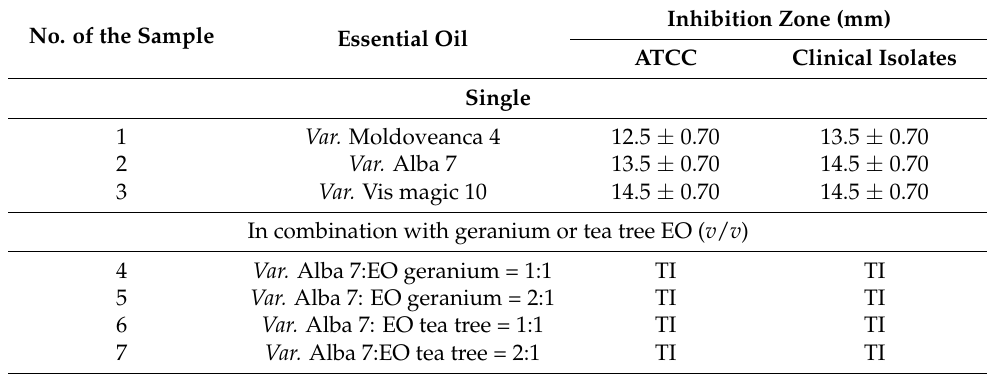
Table 6. Diameters of the inhibition zones of EOs against C. albicans